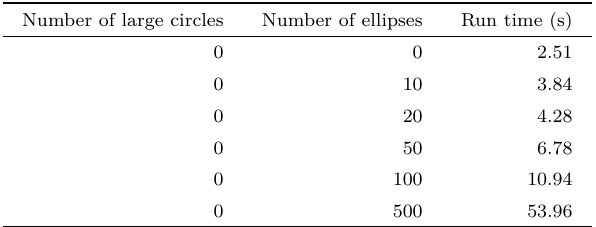
Table 3 Run time under different number of ellipses within input containing 100,040 detected fibers Number of large circles